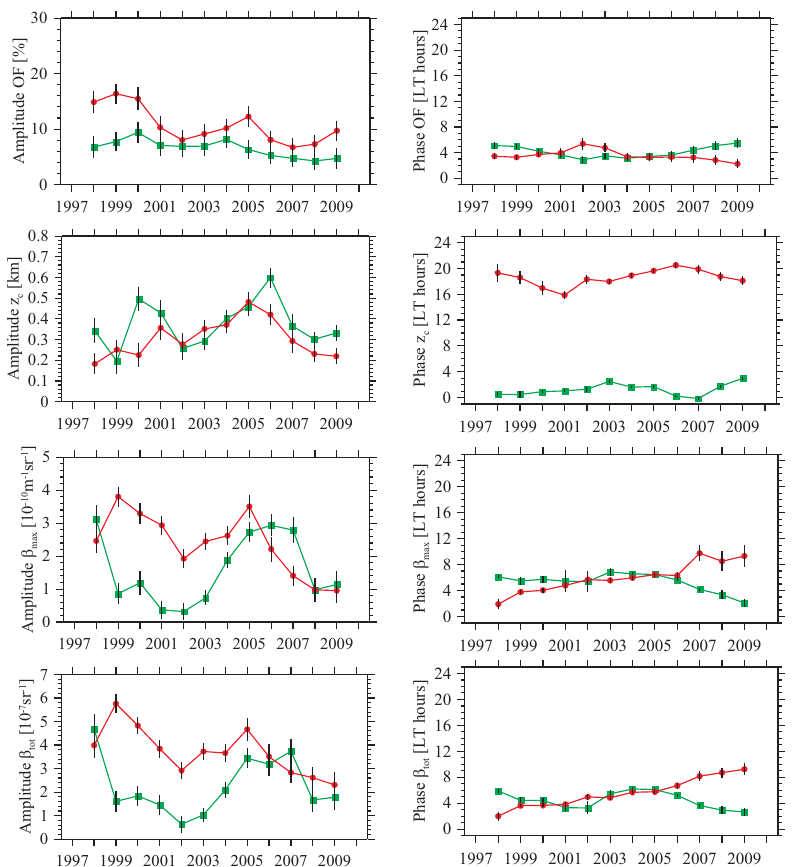
Fig. 5. Year-to-year variations of seasonal mean amplitudes and phases for 24- (red circles) and 12-h (green squares) periods of NLC parameters. From top to bottom: occurrence, altitude, brightness ( β max ), brightness ( β tot ). Based on 3 years running means for clouds above the long-term limit. Vertical bars are errors resulting from Levenberg-Marquardt least-squares fits.